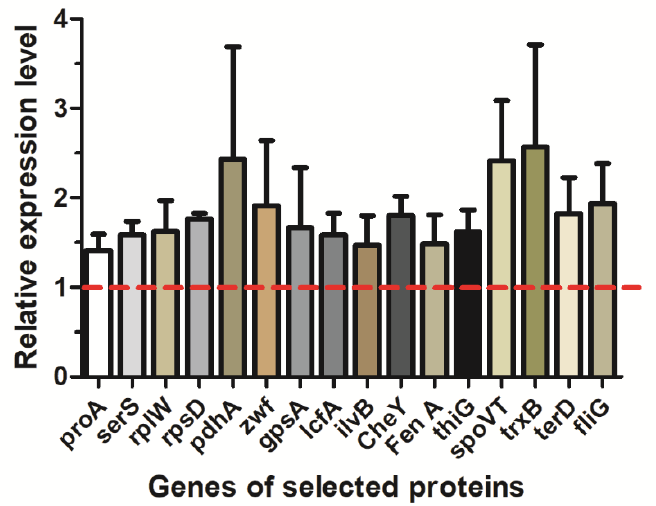
Figure 3. Relative expression levels of transcripts. Data were normalized against expression of the housekeeping gene gatB_Yqey. To determine relative fold differences for each gene, the formula 2 − ∆∆ Ct was used. ∆∆ CT = ∆ CT Treated group (CT (target gene) − CT (endogenuous reference gene)) − ∆ CT control group (CT (target gene) − CT (endogenuous reference gene)).